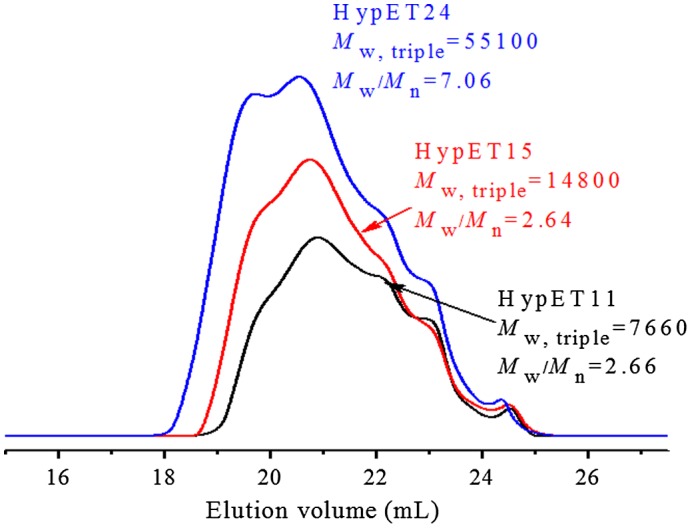
SEC-TD traces of HypET11, HypET15 and HypET24, which were prepared by Michael addition polymerization with molar ratio of EGDA/TMEA = 2/1 in chloroform.